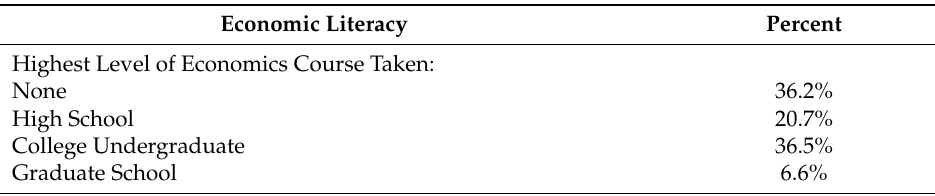
Table 4. Measures of Economic Literacy for Full Survey